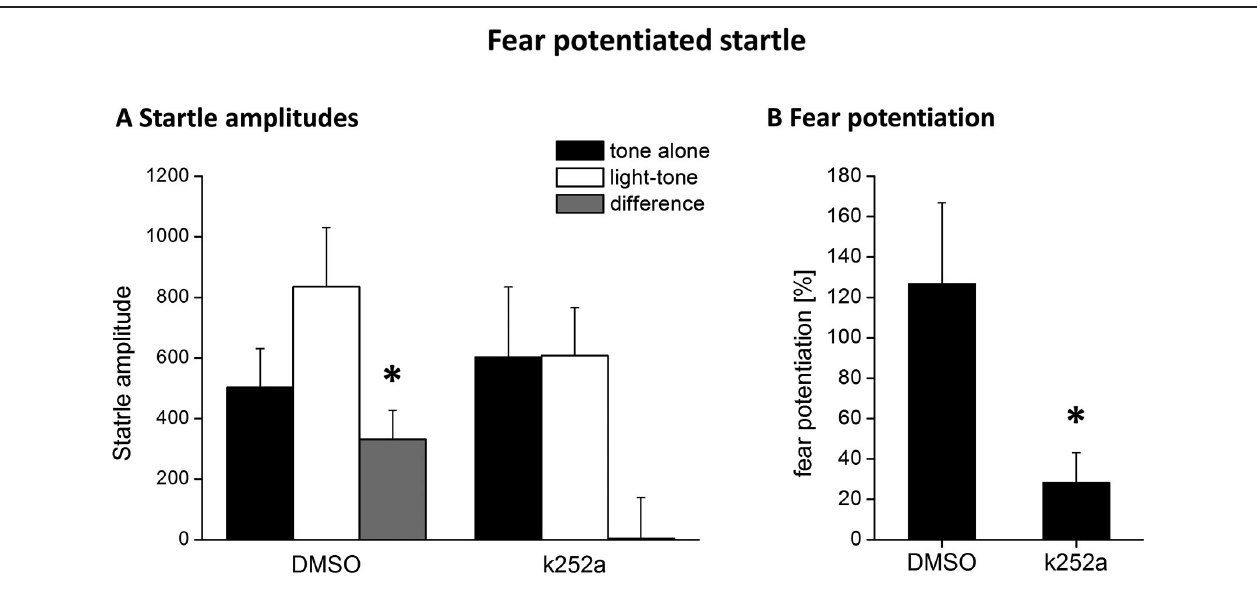
FIGURE 3 | Blocking Trk activity 120 min after fear conditioning by local k252a application impairs fear potentiation of the acoustic startle response 24 h after fear conditioning training . ( A) Mean ASR amplitude